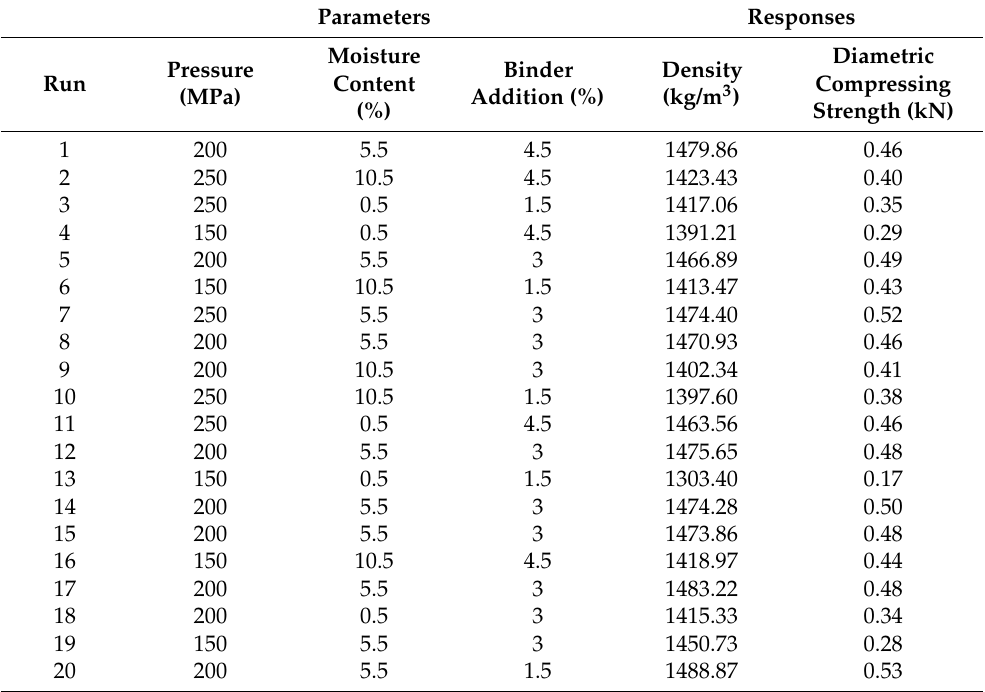
Figure 5. Effect of CL binder on the density and diametric compressing strength. Table 2. Experimental design and